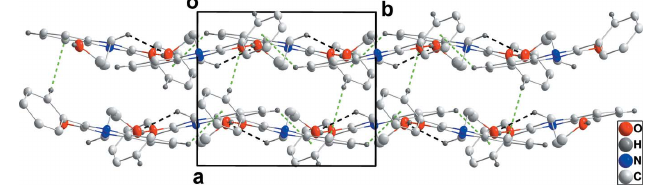
Figure 4 A view of portions of two chains viewed along the b -axis direction showing their association through C—H (cid:2)(cid:2)(cid:2) (cid:2) (ring) interactions. These and the hydrogen bonds are depicted as in Fig. 2.